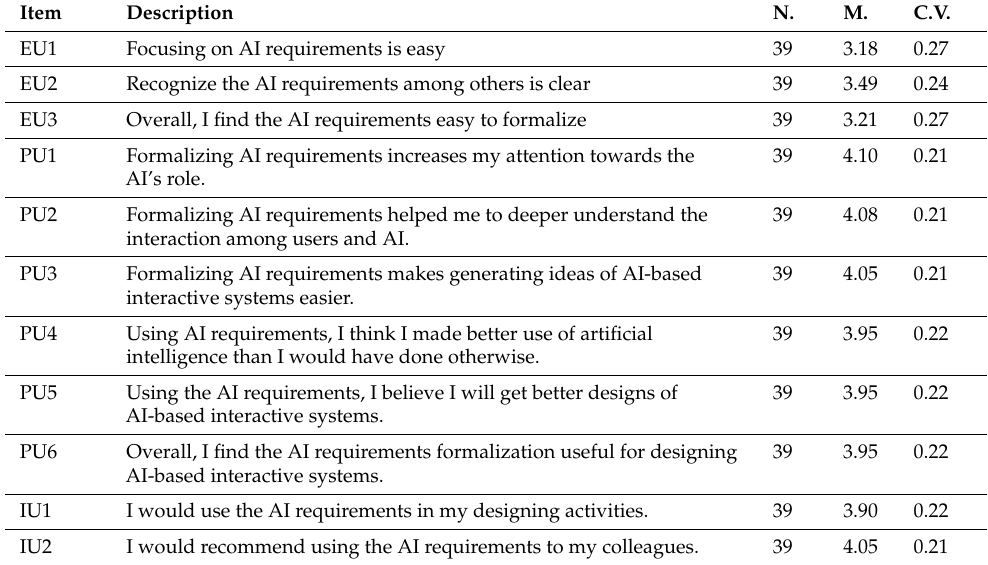
Table 3. The results of the workshop